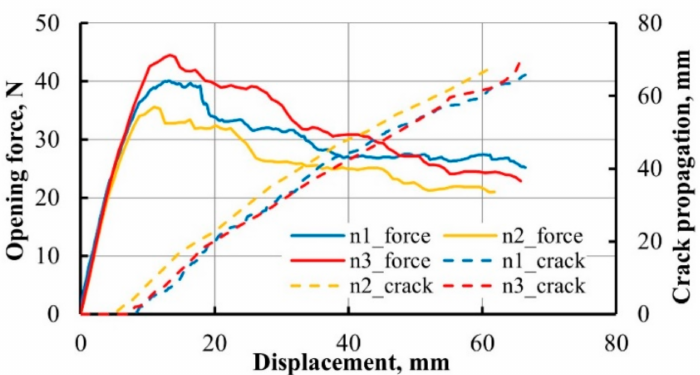
Figure 16. Opening force and crack propagation of DCB specimen vs. machine’s grips